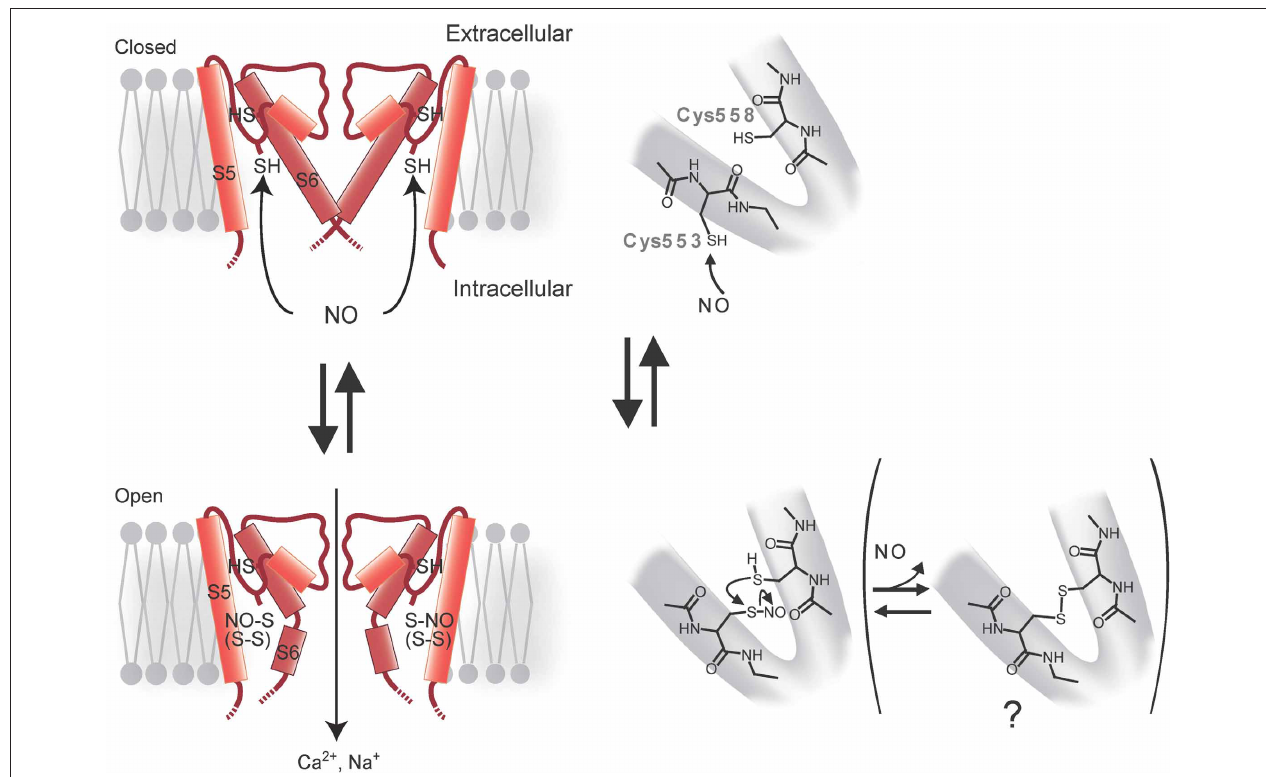
FIGURE 3 | Model for activation of TRPC5 channel by NO. Cys553 is nitrosylated by NO, which triggers TRPC5 channel opening. The free sulfhydryl group of Cys558 nucleophilically attacks nitrosylated Cys553 to form a disulfide bond that stabilizes the open state.